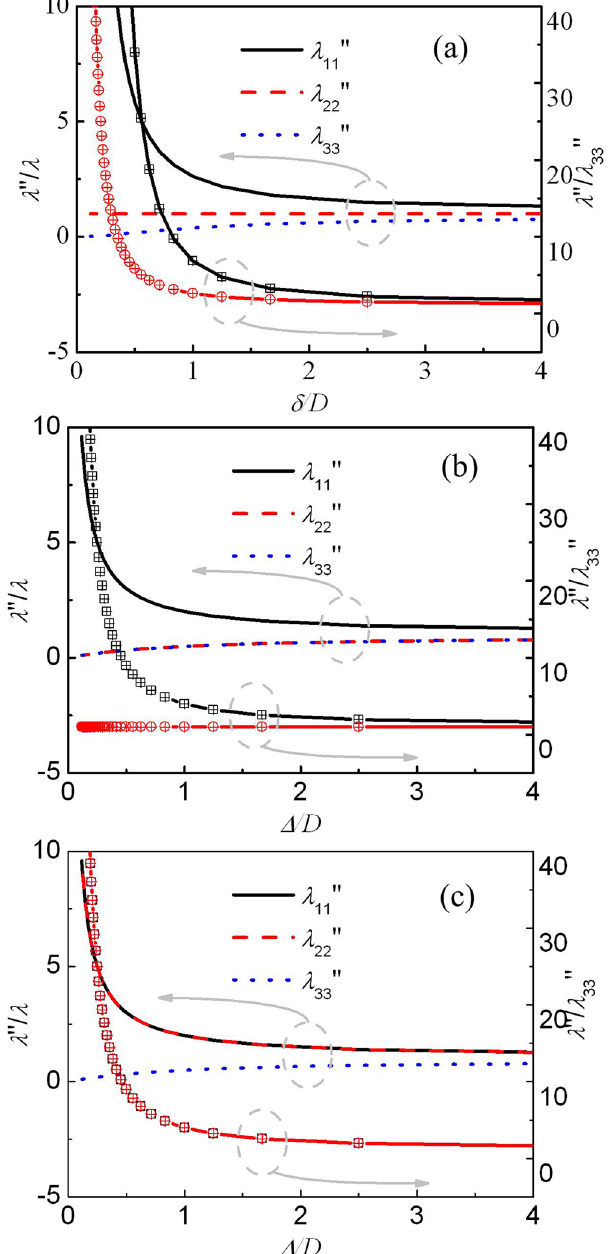
Figure 3. Thermal conductivities and anisotropies of different pyramids varying with the dimensions of the device. ( a ) Properties of the top, bottom, front and back pyramids varying with thickness δ . ( b ) Properties of the left pyramid varying with thickness Δ . ( c ) Properties of the right pyramid varying with thickness Δ